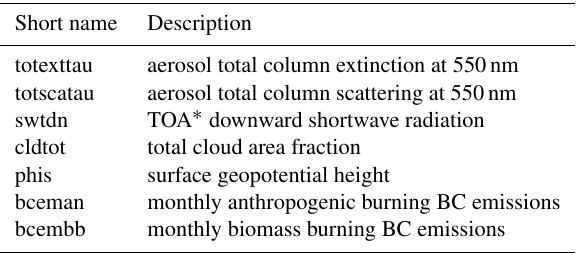
Table 1. G5NR data used in this